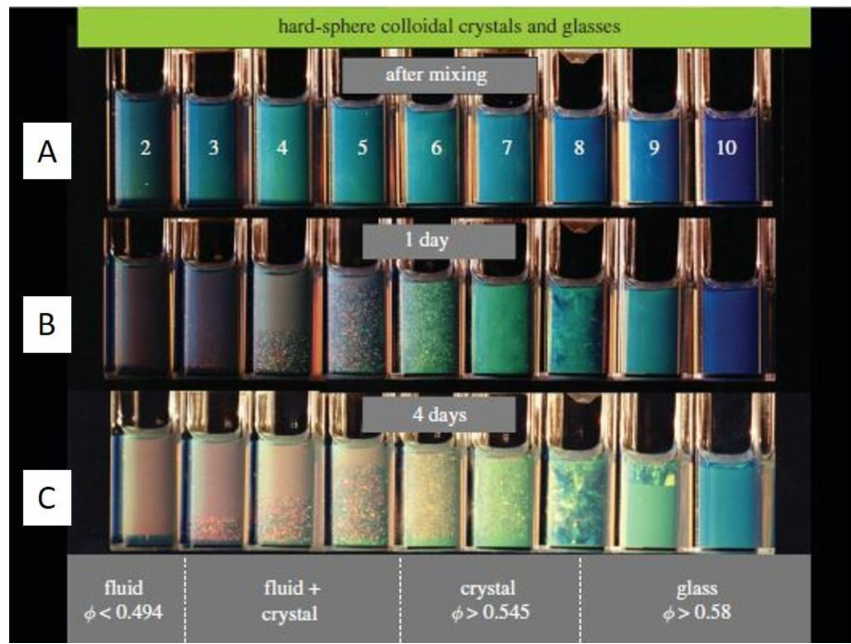
Figure 1. Hard-sphere latex suspensions in cuvettes, illuminated obliquely from behind by white light, ( A ) immediately after mixing, ( B ) after 1 day, and ( C ) after 4 days. In the lowest column (after 4 days), the lower part of the right cuvettes shows the glassy phase with the volume fraction larger than 0.58, the middle cuvettes show the nucleated crystal phase with the volume fraction between 0.545 and 0.58 while the left cuvettes show mostly the fluid phase when the volume fraction is lower than 0.494. Reproduced with permission from [18], Copyright the Royal Society,